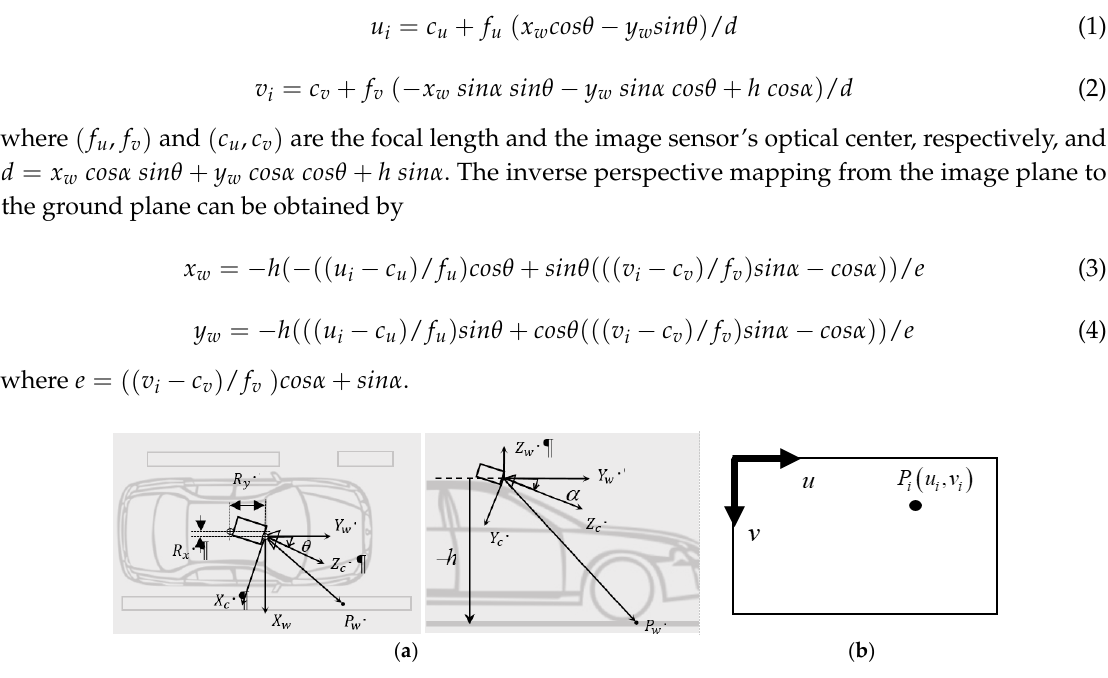
Figure 1. ( a ) An image sensor (dashcam) with the camera frame ( X c , Y c , Z c ) mounted on a vehicle at height h above ground with pitch angle 𝛼 , yaw angle 𝜃 , and offset (𝑅 (cid:3051) ,𝑅 (cid:3052) ) from the vehicle center in the world frame ( X w , Y w , Z w ) , and ( b ) illustration of the image sensor plane, where point P i is the projection on the image plane of a point 𝑃 (cid:3050) on the ground.